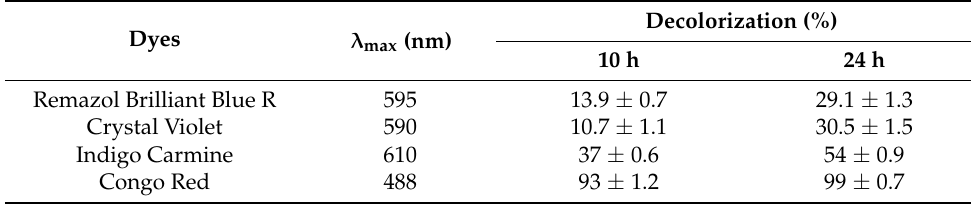
Table 3. Decolorization of the synthetic dyes using Melac13220; reaction mixture contained 1.0 U/mL of pure enzyme, 80 mg/mL of synthetic dyes in 20 mM Tris-HCl buffer (pH 7.5) for Congo Red and 20 mM Gly-HCl buffer (pH 1.5) for other dyes. The values represent the mean ± standard deviation of three independent measurements.